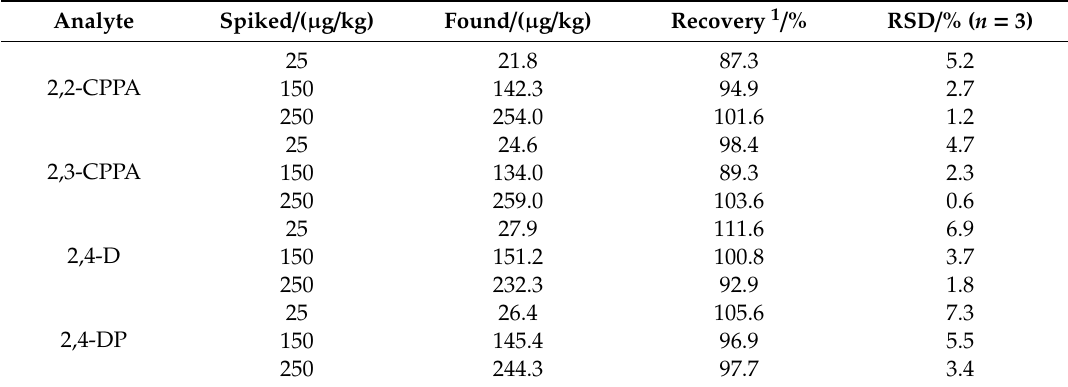
Table 2. Recoveries of four CAHs in rice grains.